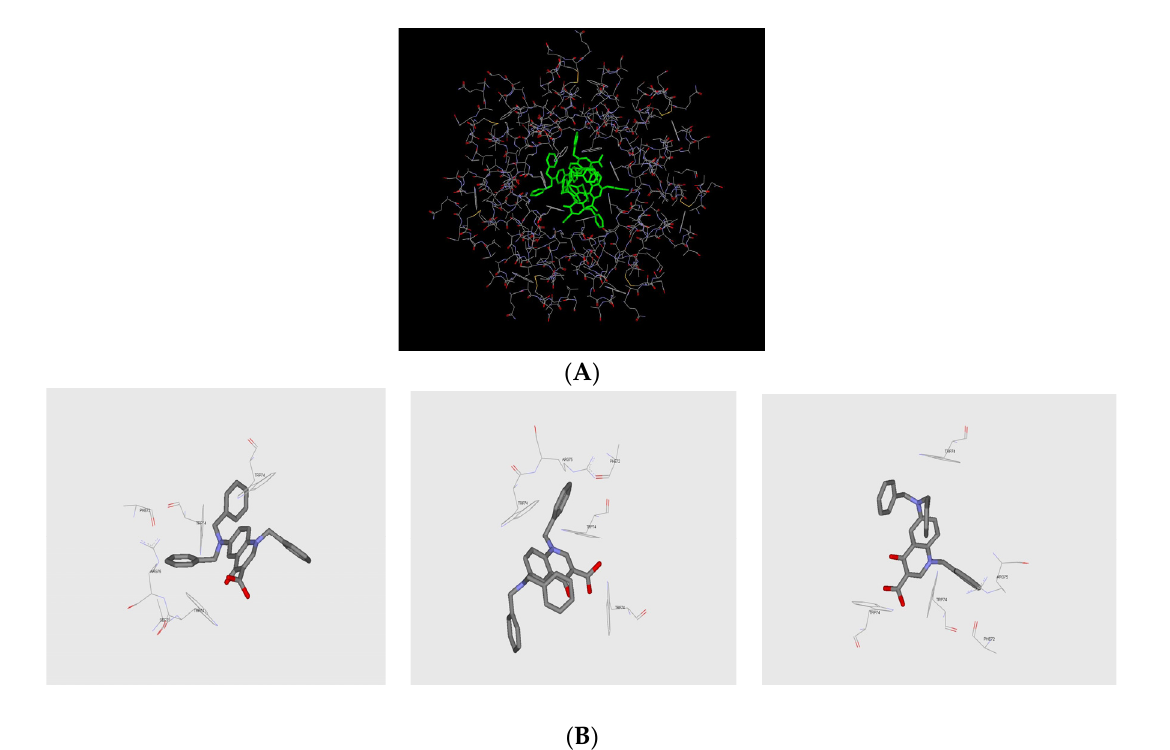
Figure 10. Docking of compound 13e . Two lower-energy poses of 13e in the extracellular domain of the PANX1 channel (panel A ). Particular of the hydrogen bond interactions between 13e and the Ile60 and Trp74 (panel B ).